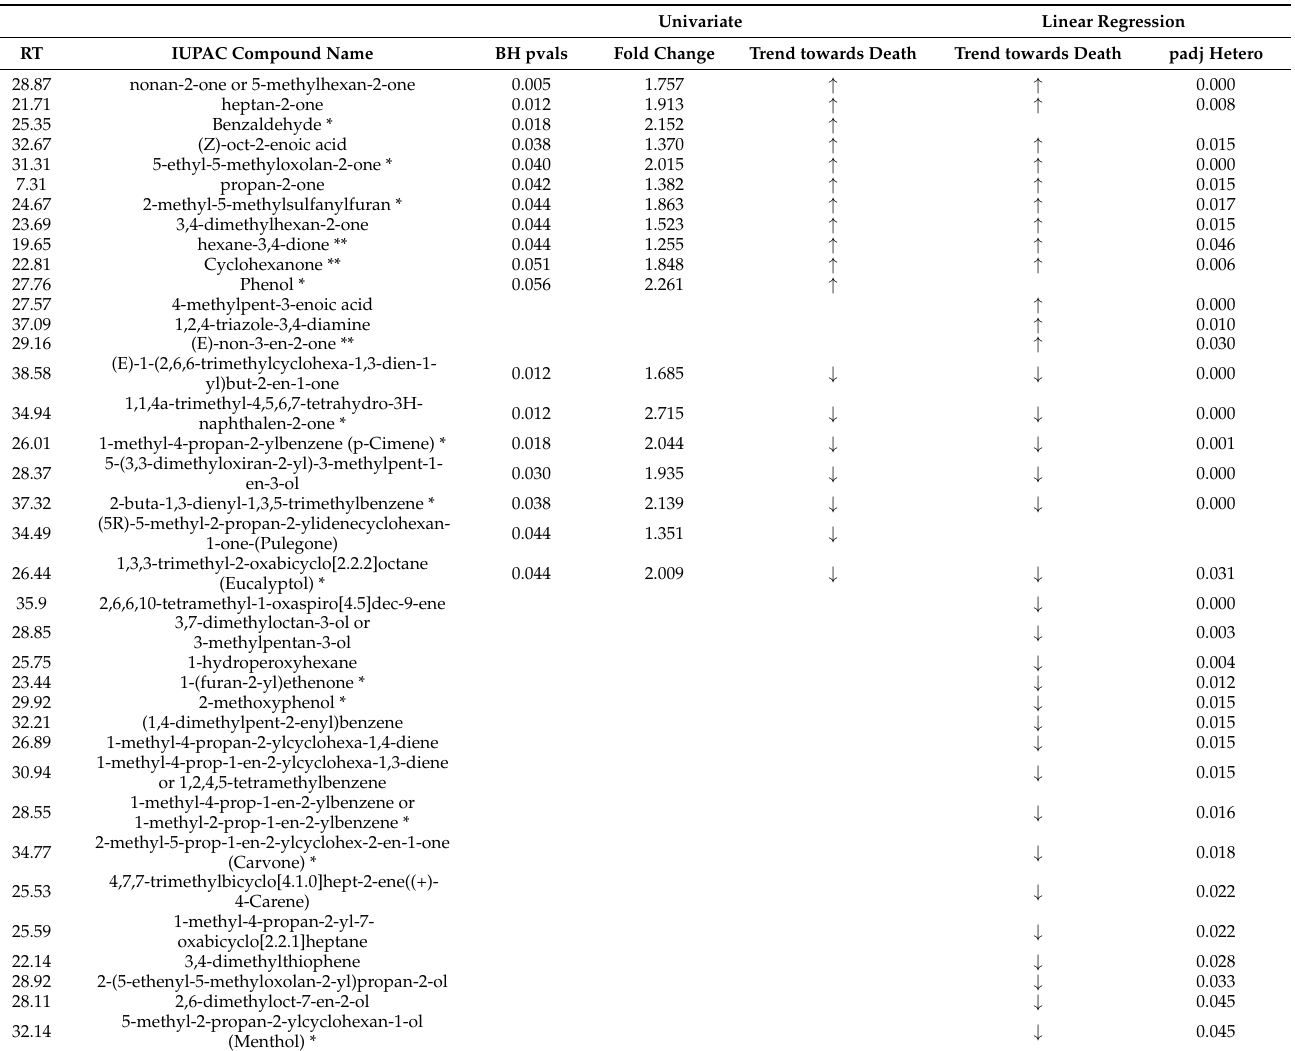
Table 2. The 37 VOCs shown to change towards death by univariate analysis and linear regression analysis in the acid dataset.